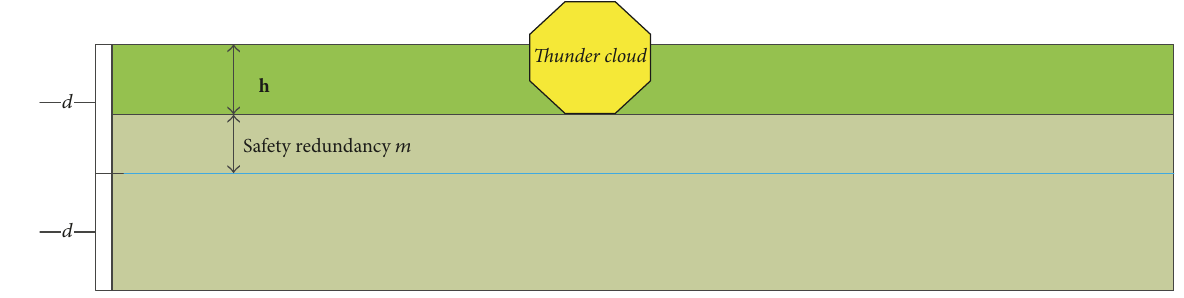
Figure 2: Coverage of a single weather module in the terminal area.